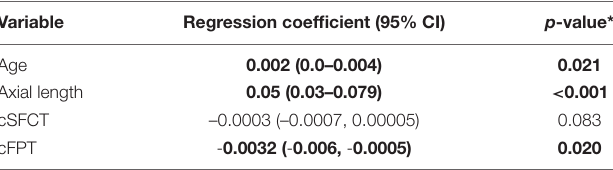
TABLE 4 | Association between BCVA with age, axial length, corrected SFCT, and corrected